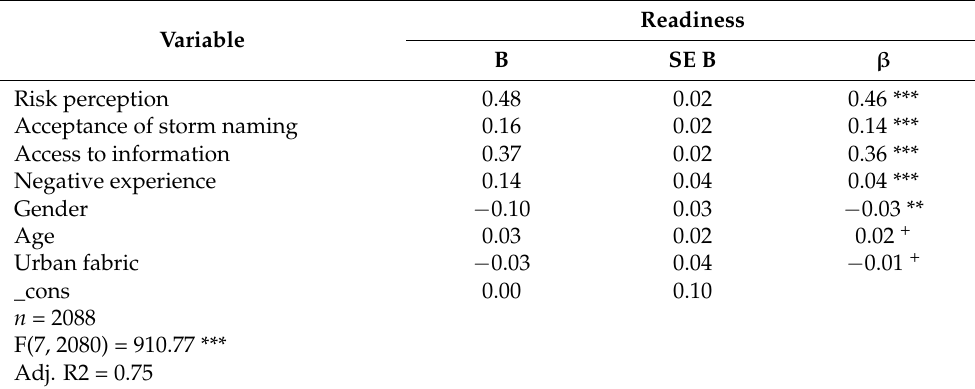
Table 2. Regression results explaining individual readiness for named storms.